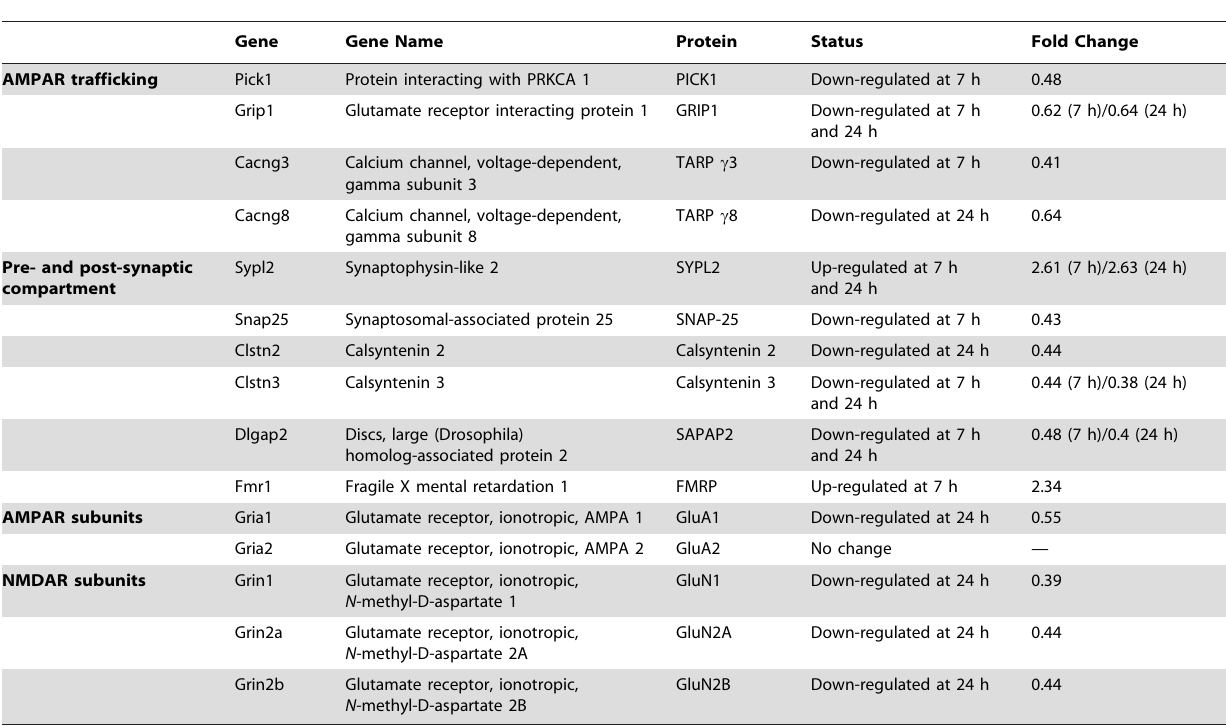
Table 1. Microarray data showing the effect of OGD in the mRNA levels of genes encoding synaptic